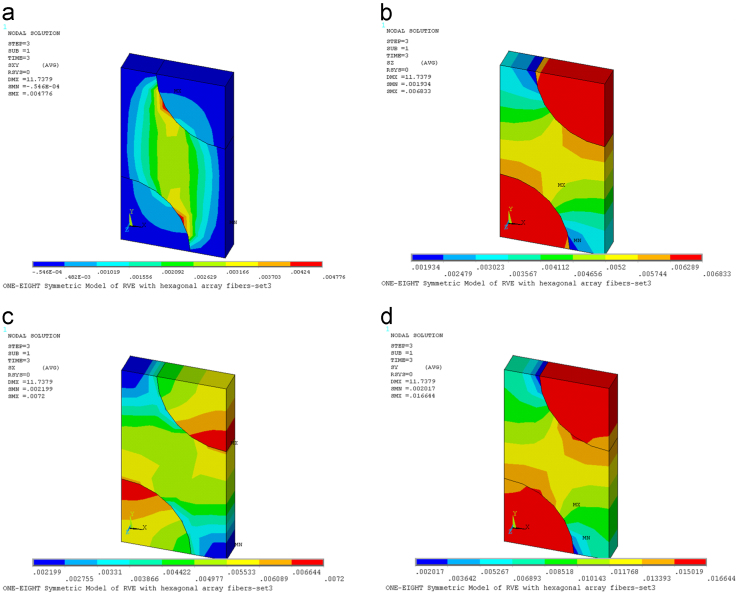
(a) Contour plot of stresses τxy on deformed RVE [TPa]. (b) Contour plot of stresses σz on deformed RVE [TPa]. (c) Contour plot of stresses σx on deformed RVE [TPa]. (d) Contour plot of stresses σy on deformed RVE [TPa].